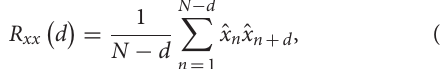
Frontiers in Physiology |